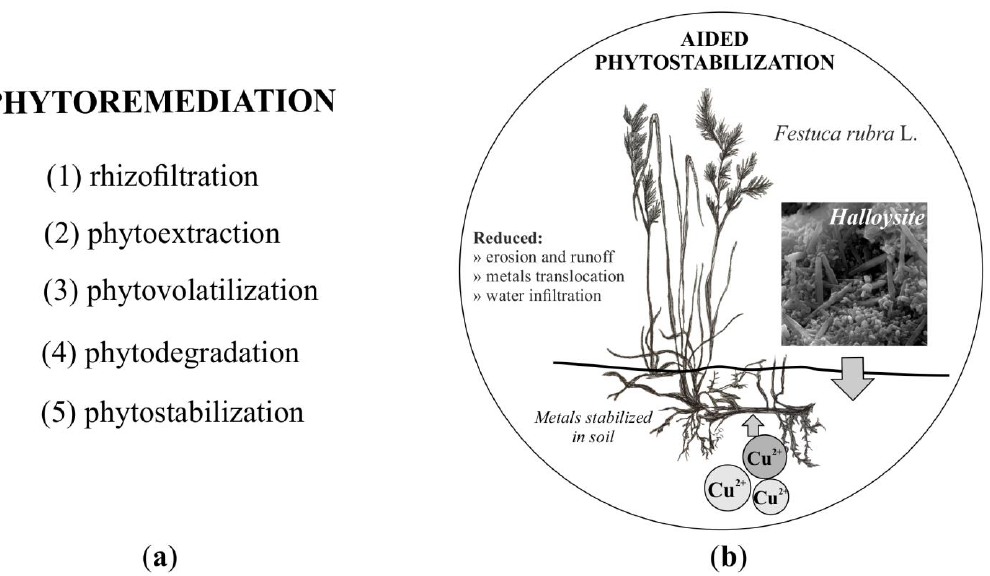
Figure 1. ( a ) Classification of phytoremediation methods; ( b ) concept of aided phytostabilization using halloysite and red fescue ( Festuca rubra